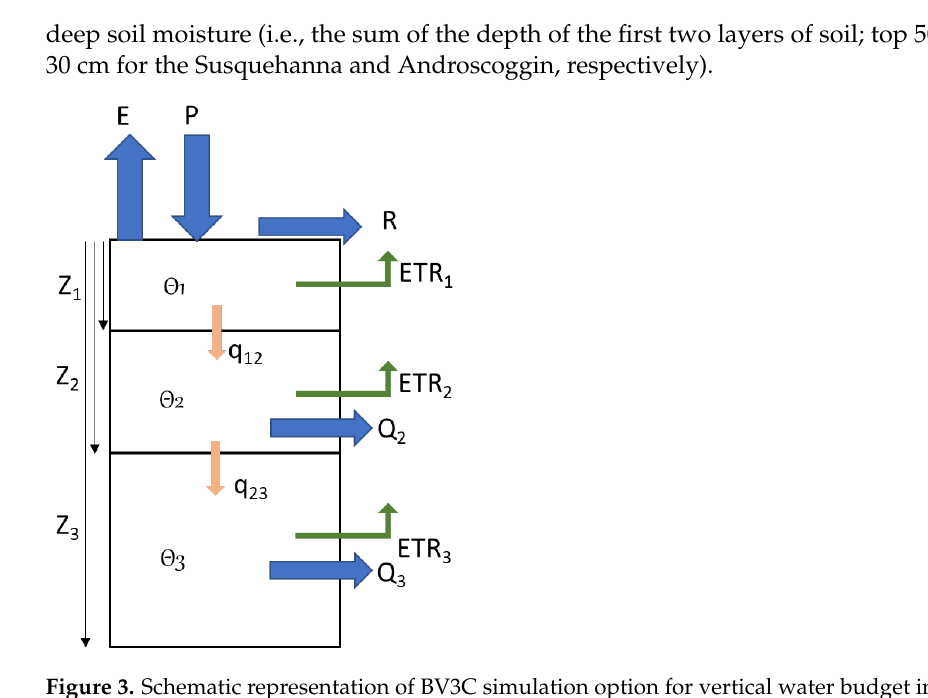
Figure 3. Schematic representation of BV3C simulation option for vertical water budget in HYDRO- TEL. The thicknesses of the 3 soil layers are represented by Z 1 , Z 2 , and Z 3 , and the associated soil moisture are Θ 1 , Θ 2 , and Θ 3 , and the relative real evapotranspiration ETR 1 , ETR 2 , and ETR 3 , respec- tively. Total evaporation, precipitation and surface runoff are designed by E, P, and R, respectively. The interflow and the baseflow are represented by Q 2 and Q 3 , and the baseflow, respectively.